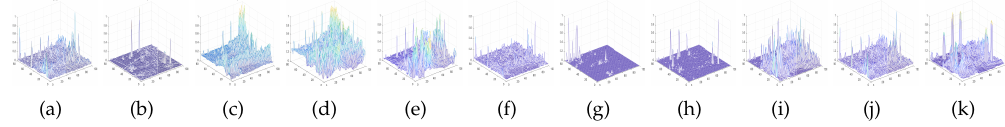
Figure 16. Three-dimensional plots of detection results for the Urban dataset. ( a ) GRX; ( b ) BJSRD;